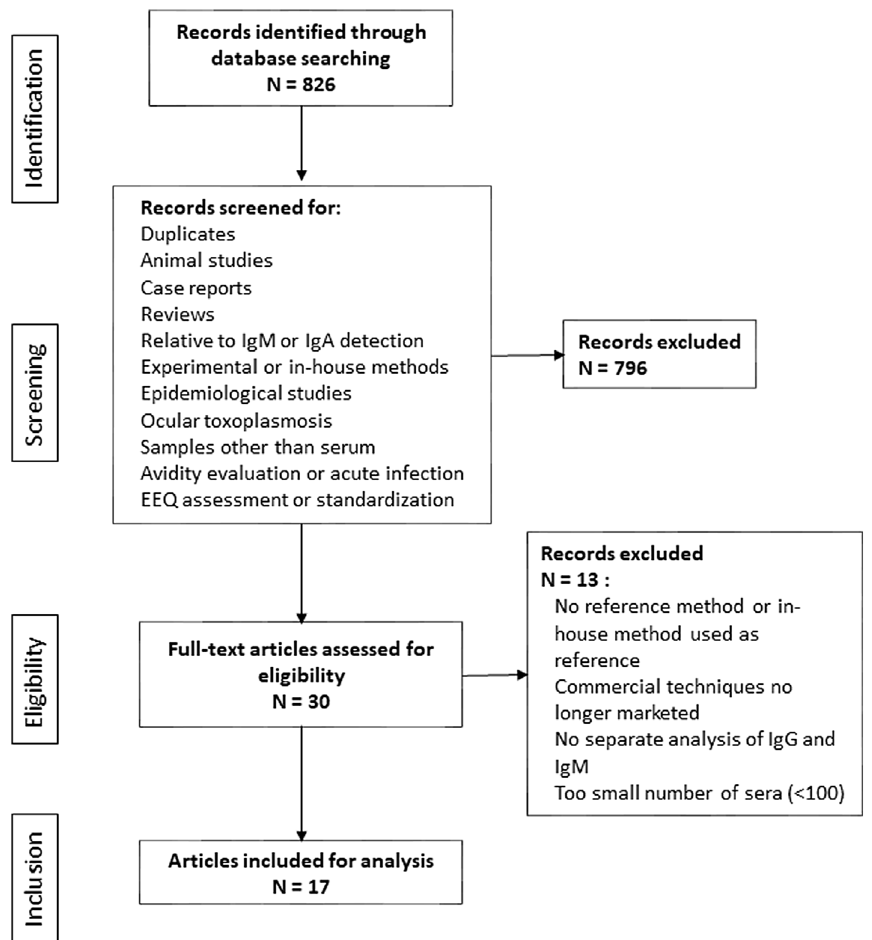
Figure 1. Flow chart of article selection for